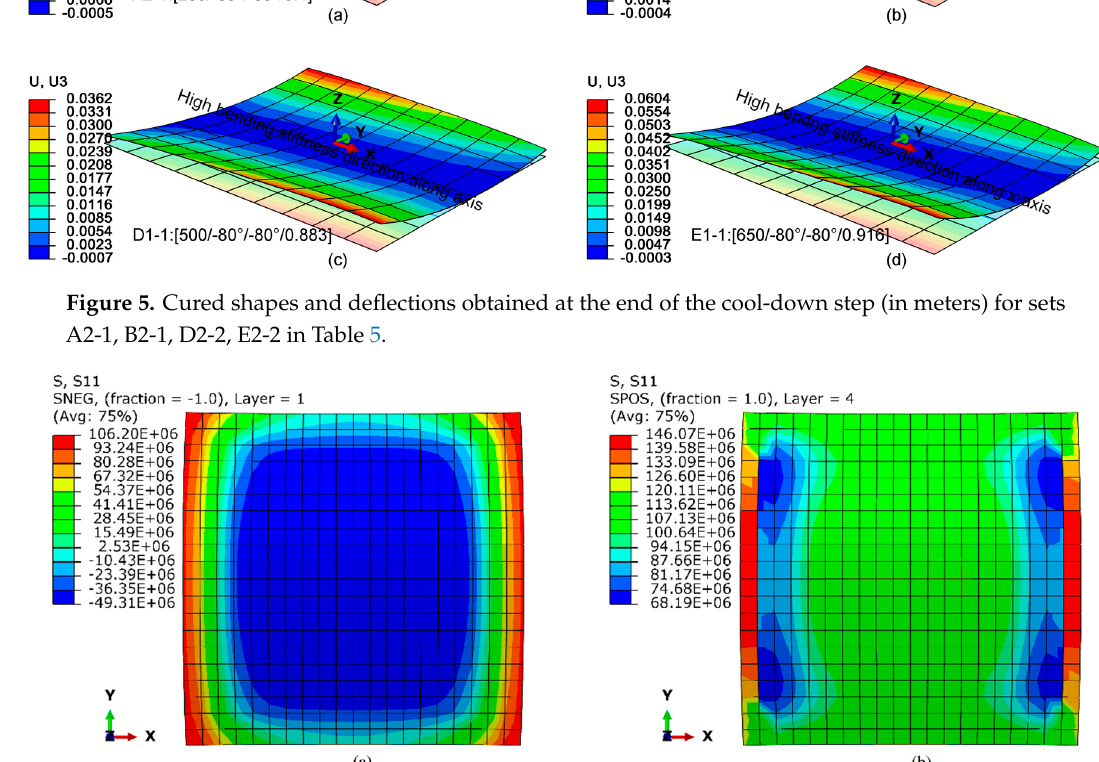
Figure 6. Axial stress distribution in SMAC—( a ) 0° fiber-oriented bottom layer; ( b ) 90° fiber-oriented top layer.